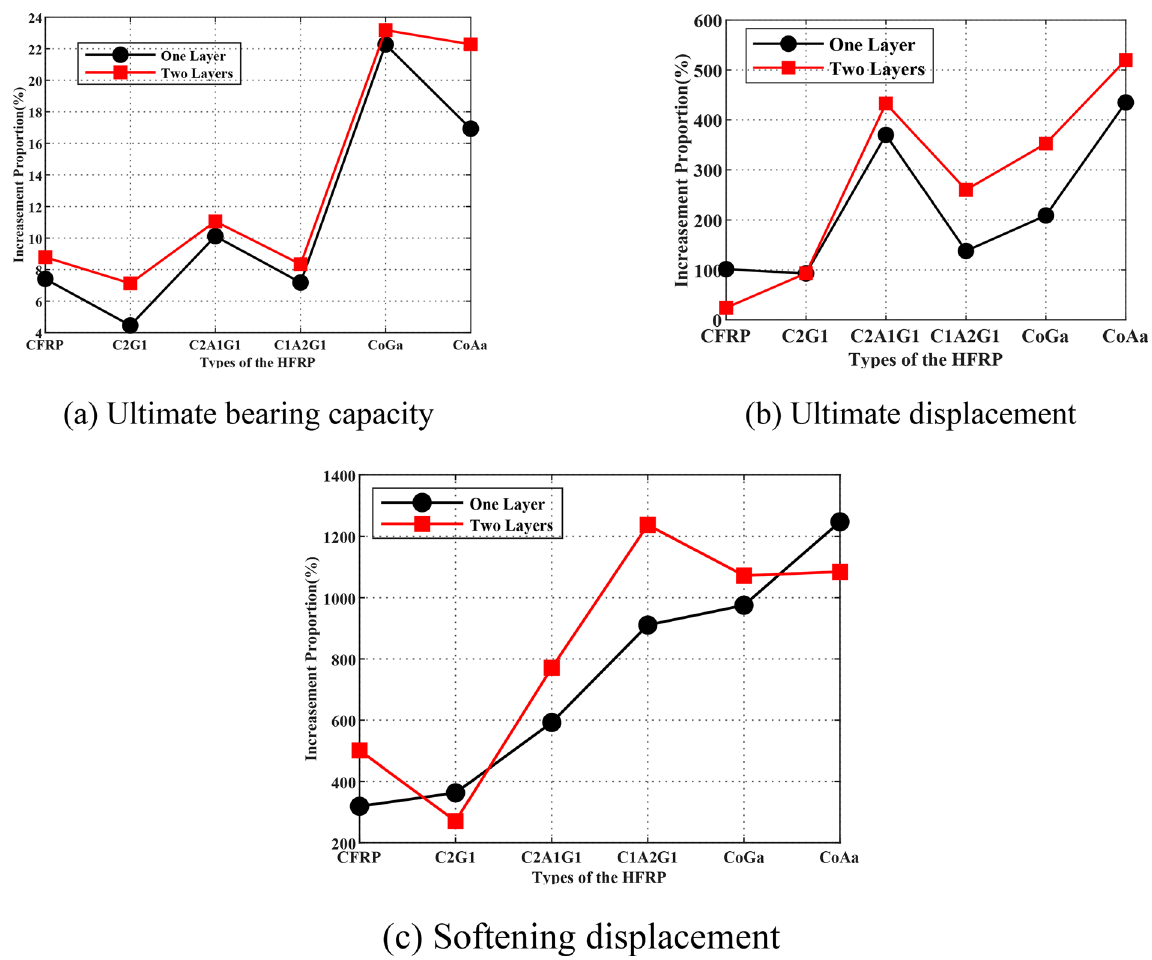
Fig. 14 The effect of different sheet types and different reinforced